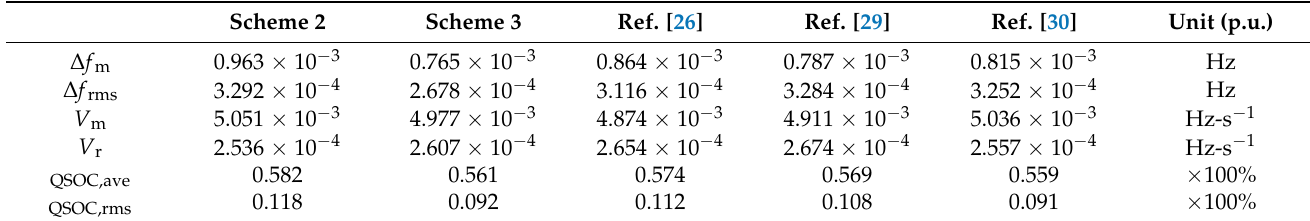
Table 6. Comparative table of